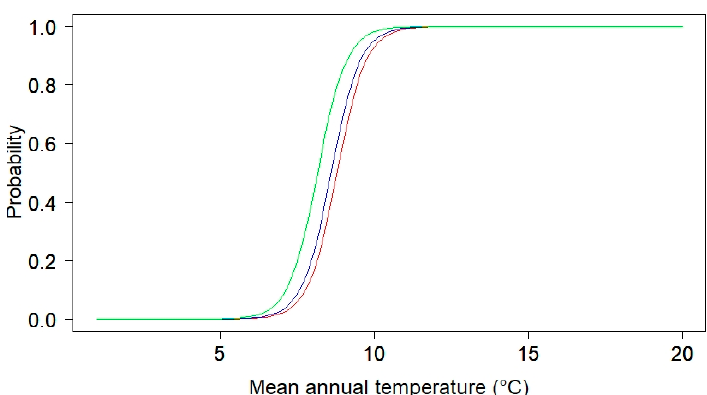
Figure 2. The probability of damage to box trees by Cydalima perspectalis predicted by mean annual temperature. Red line—high damage; blue line—high or medium damage; and green line—any damage (high, medium, or low damage).